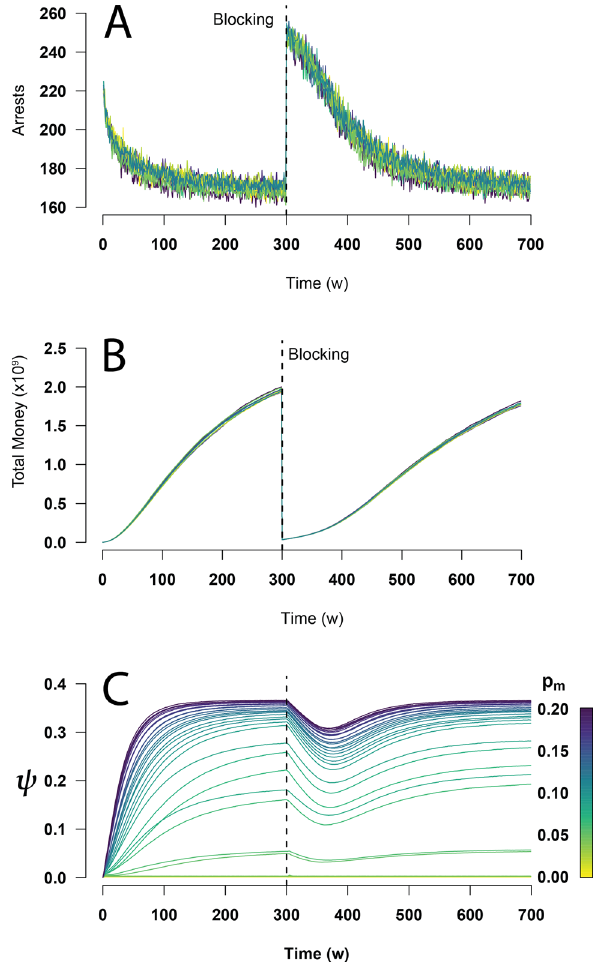
Figure 6. Effect of money seizure. After 2700 time steps (300 weeks) the money of 80% of the richest criminals in the criminal network is seized (or blocked), indicated by the vertical dashed line in all the plots. ( A ) Number of arrests as a function of time. Immediately after the money has been blocked, the arrests sharply increase since criminals do not have enough money to bribe police officers and get away. ( B ) The total amount of money in the criminal network abruptly decreases after the blocking. However, both the number of arrests and the amount of total money rapidly return to the stationary values observed before the blocking. ( C ) Surprisingly, contrary to what happens with the number of arrests and the accumulated criminal money, the crime incidence ψ is barely affected by the money blocking. The simulations for this figure were carried out for systems with N = 10 5 and α = 0